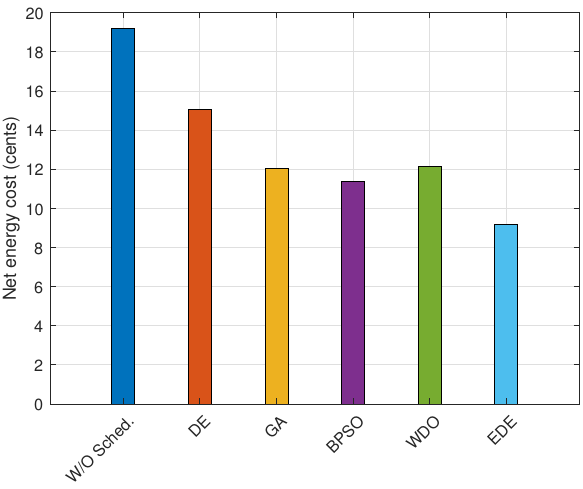
Figure 10. Interruptible appliances energy cost evaluation. Table 7. Numerical results of net energy cost evaluation after scheduling interruptible